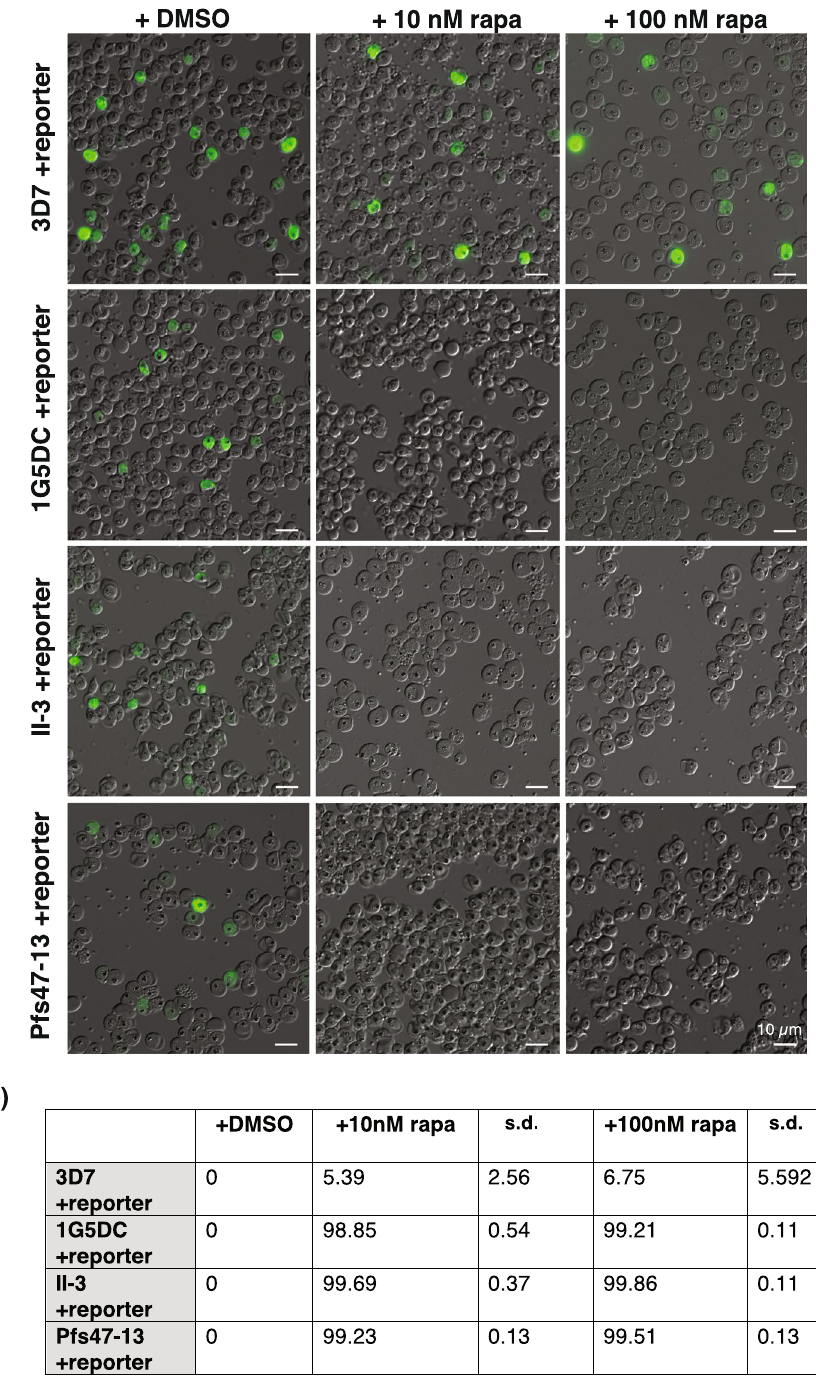
Figure 5. The new transgenic parasite lines expressing DiCre recombinase excise floxed DNA sequences with > 99% efficiency using rapamycin at lower concentrations and short treatment times. ( a ) Live GFP fluorescence assay of wild type and DiCre transgenic parasite lines transfected with the reporter plasmid pHH3-SP-loxPint-GFP-loxP and treated at the early ring stage with DMSO or rapamycin as indicated on top of the panels. Images were taken 40 h later. Size bars equal 10 μ m. ( b ) Excision efficiency determined by flow cytometry. The four parasite lines transfected with the reporter plasmid were treated with DMSO or rapamycin as described above and the number of GFP positive schizonts was counted 38–40 h after treatment. Data correspond to the mean and standard deviation (s.d.) calculated from three independent experiments counting 100,000 cells each